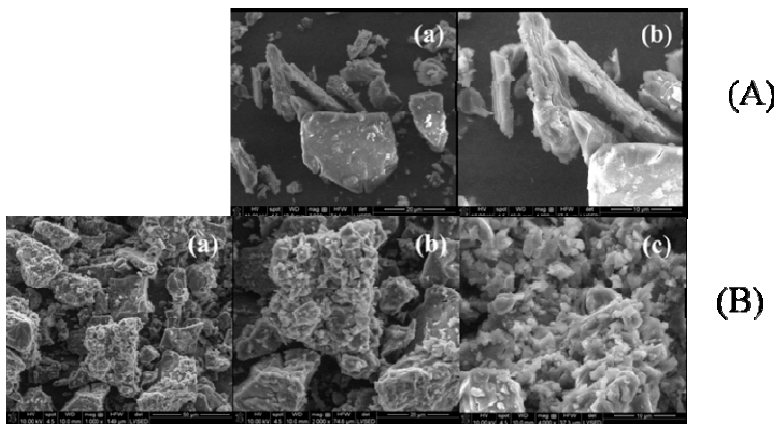
Figure 3. SEM images of ( A ) the CAP- β -CD physical mixture at different magnifications: ( a ) 2000× and ( b ) 4000×, and( B ) the CAP- β -CD inclusion complex at different magnifications: ( a ) 1000×, ( b ) 2000× and ( c ) 4000×.